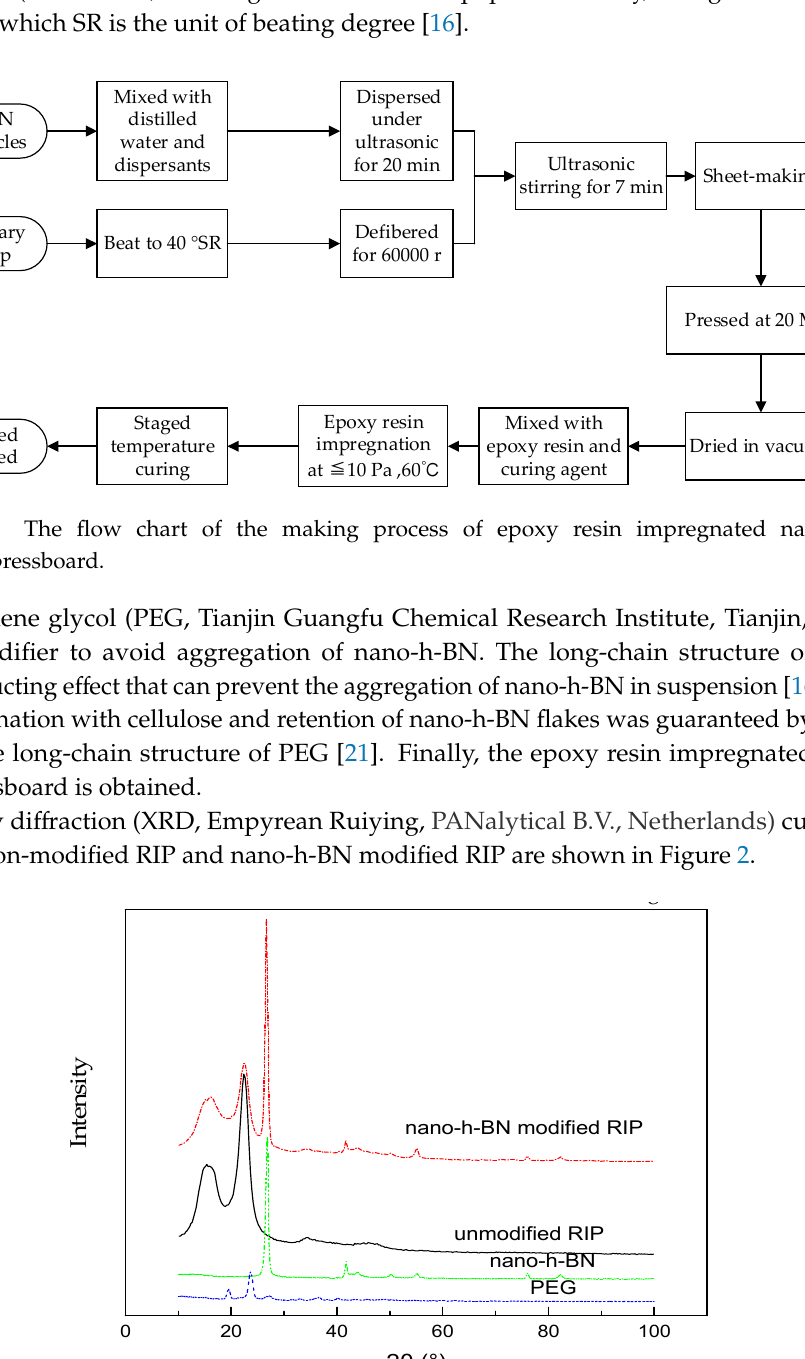
Figure 2. XRD (X-ray diffraction) spectra of nano-h-BN, PEG, unmodified and nano-h-BN modified RIP (epoxy resin-impregnated insulation paper).